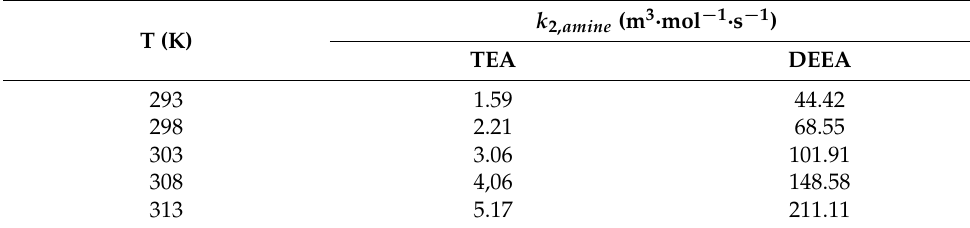
absorption into aqueous TEA and DEEA Solutions. 2